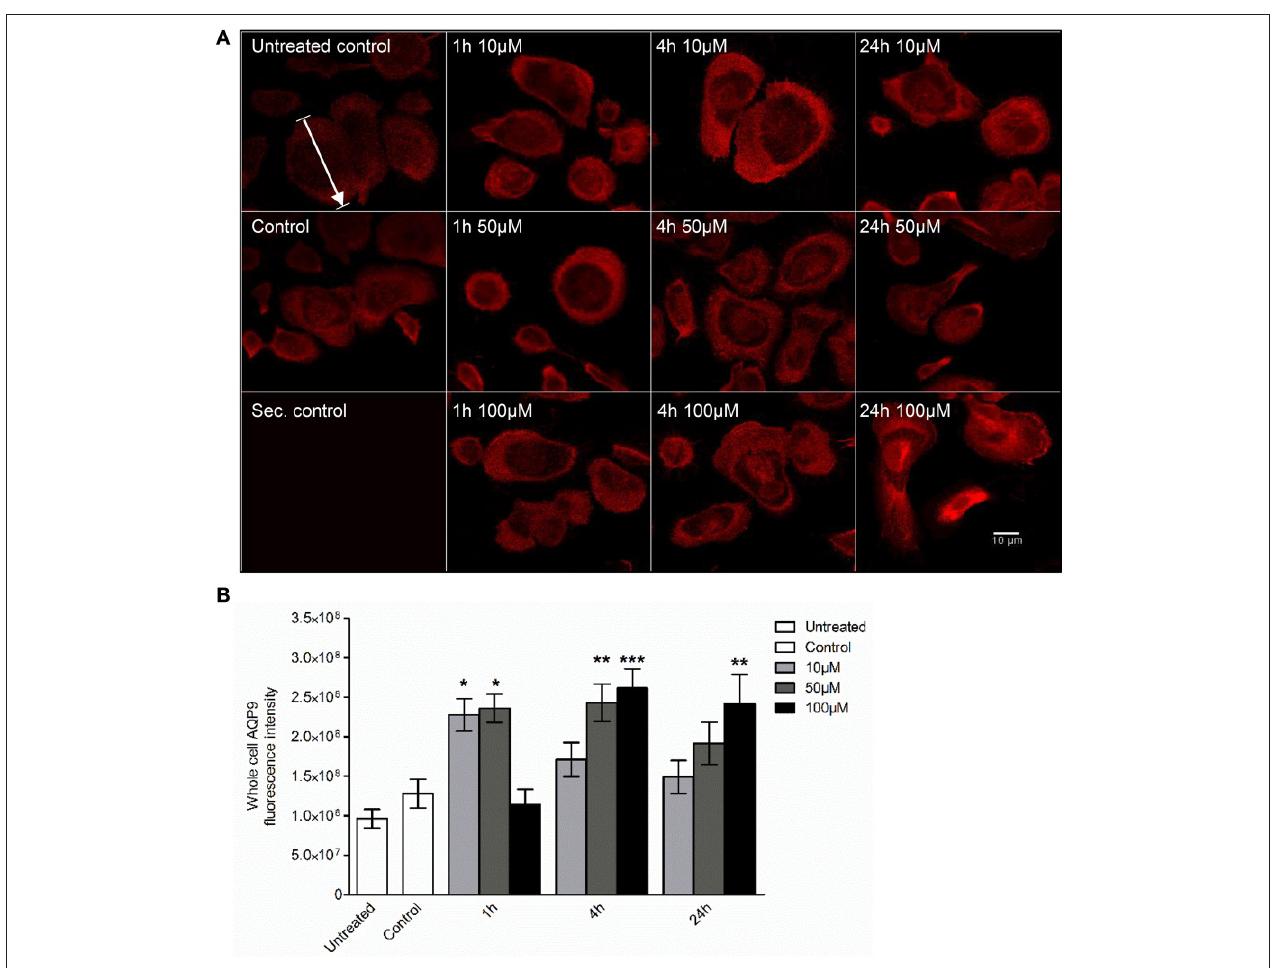
FIGURE 4 | Visualization of AQP9 cellular distribution in 3O-C 12 -HSL-stimulated macrophages. (A) Macrophages were either untreated (Untreated control), or treated with diluent (Control), or stimulated with 10, 50, and 100 µ M 3O-C 12 -HSL for 1, 4, or 24h, stained for AQP9 (red) and analyzed by LSCM. Staining with secondary antibody (Sec. control) as a control. The data are from one of six independent experiments. Bar 10 µ m. (B) Quantification of AQP9 immunofluorescence intensity measured as a total integrated intensity density of whole macrophage area. Columns represent the means ± SE. Significant differences are indicated with * when P < 0.05, ** when P < 0.01, and *** when P < 0.001, as analyzed by one-way ANOVA and Dunnett’s multiple comparison test. Data from at least four different experiments performed on separate days from six different donors were used, and at least 100 cells in total per condition were